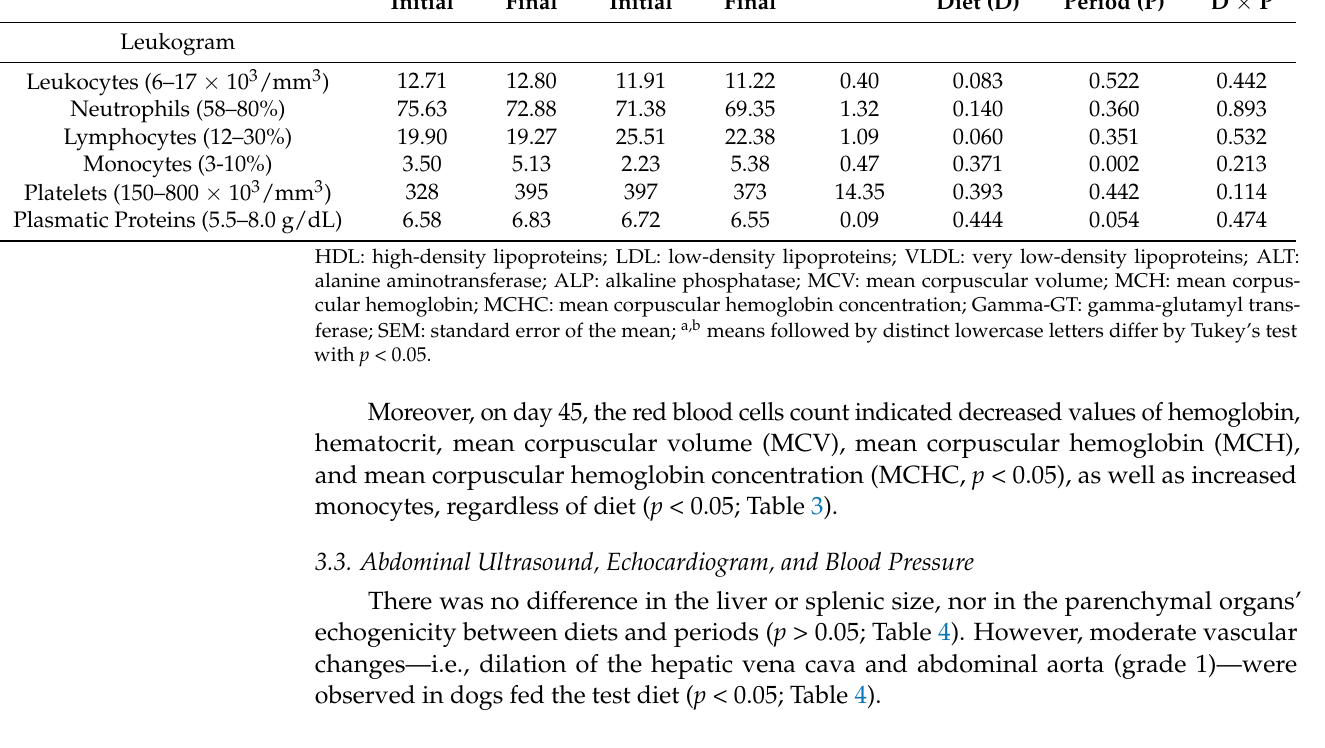
Table 4. Medians (1st; 3rd quartiles) of ultrasound variables of the abdominal region of dogs fed diets containing choline chloride (control) or an herbal source of choline